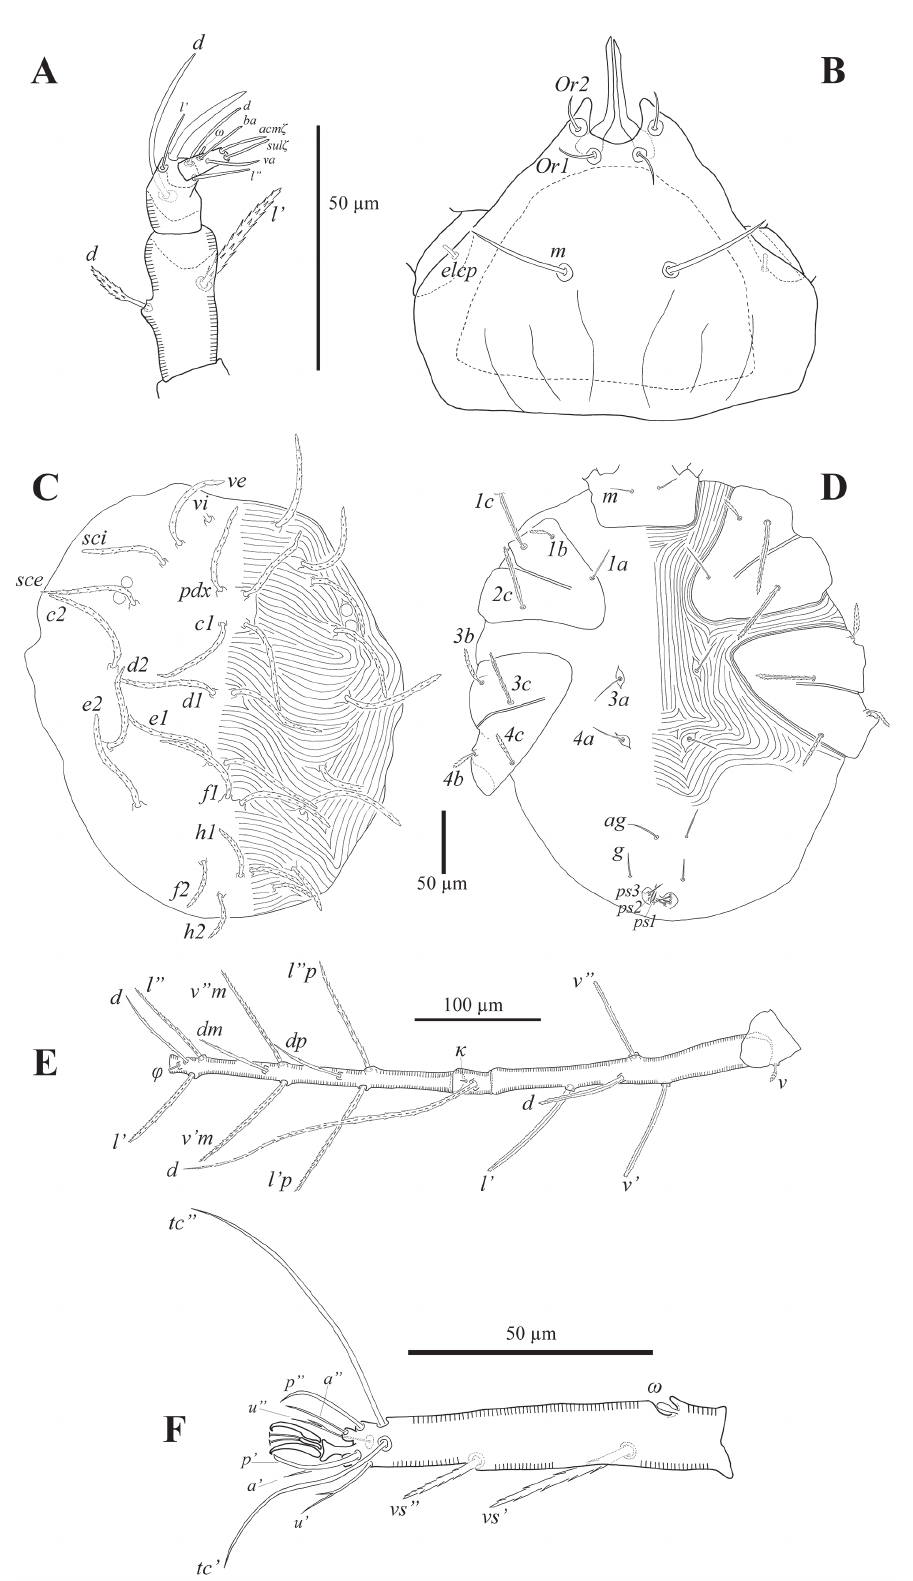
Fig. 6. Neophyllobius tescalicola sp. nov., ♀, holotype. A . Palp. B . Subcapitulum. C . Dorsal idiosoma. D . Ventral idiosoma. E . Trochanter–tibia of leg I. F . Tarsus